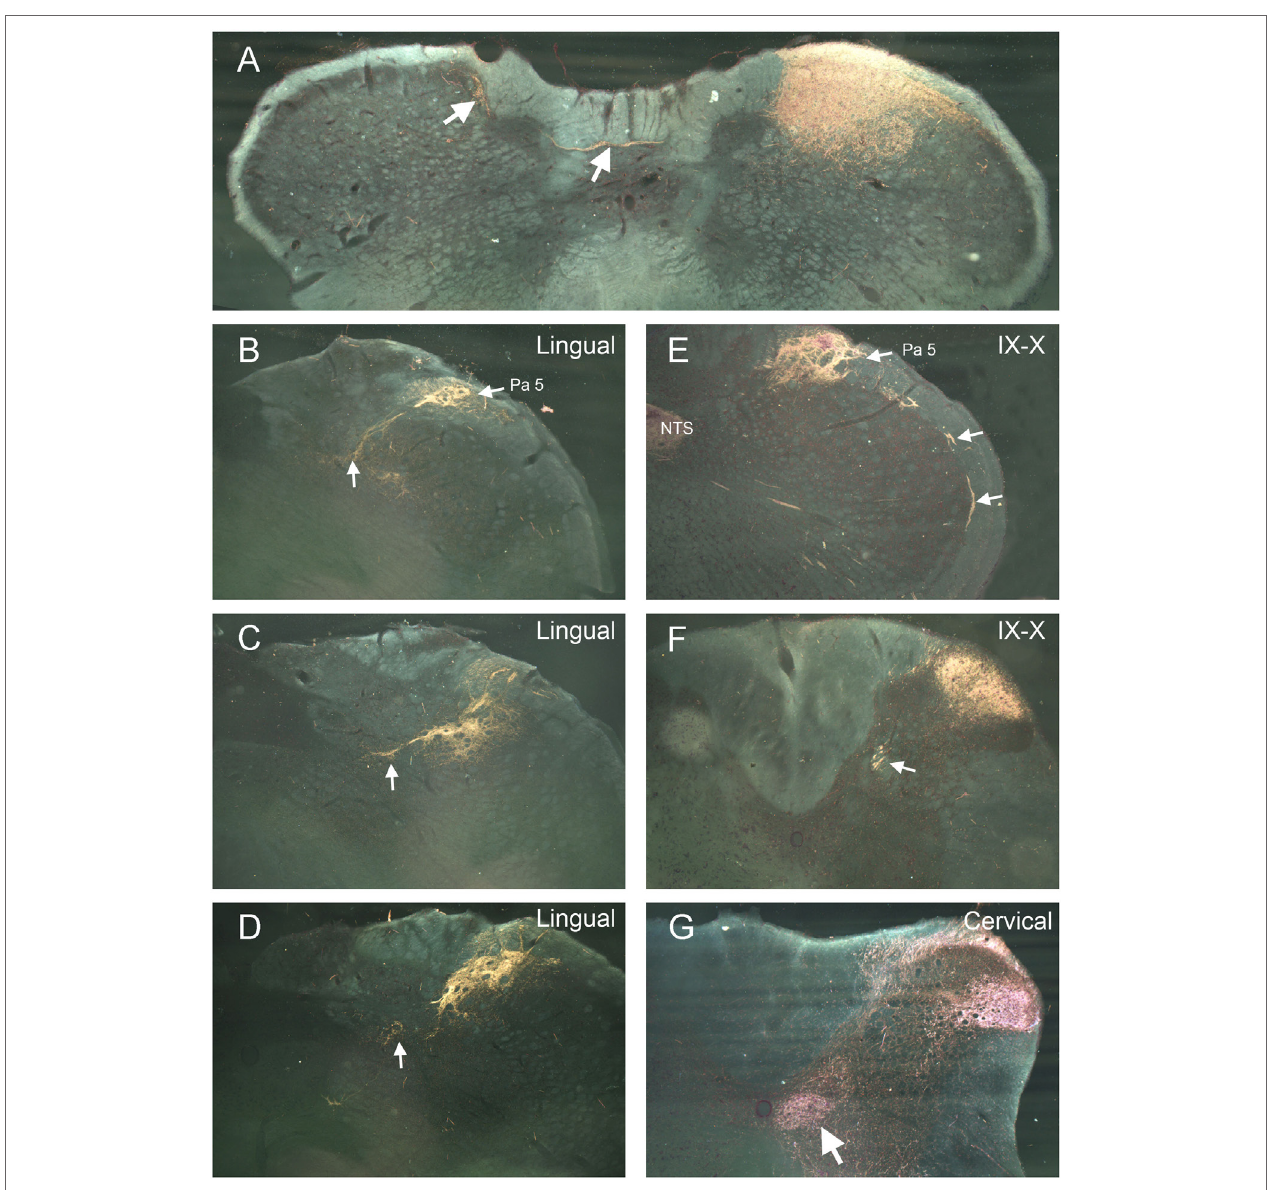
FigUre 2 | Darkfield photomicrographs illustrating selected projections after transganglionic transport of a horseradish peroxidase (HRP) cocktail injected into different nerves of the head and neck. Injections of cutaneous nerves with receptive fields along the midline, including the supraorbital and mental (the terminal branch of the inferior alveolar n.) nerves, resulted in reaction product in homologous areas of the contralateral trigeminocervical complex. The route for crossing fibers and their contralateral destination for the mental nerve (inferior alveolar n.) are shown (a) . Injections of the lingual nerve resulted in reaction product in the dorsolateral reticular formation, encroaching on the ventrolateral subnucleus of the nucleus of the solitary tract [ (B–D) ; arrows] as well as dense label in laminae I and II of the ipsilateral medullary dorsal horn (MDH) (D) . Panels (B,e) illustrate the dense reaction product in the paratrigeminal nucleus (Pa5) after injections of the lingual and IX/X nerves. Reaction product is seen in laminae I and II, the nucleus of the solitary tract (NTS), as well as intense label in the presumptive lamina I of the rostral MDH [ (e) ; arrows] after injection of IX/X nerves. It is well known that the glossopharyngeal and vagus nerves have receptive fields on the pinna; (F) shows reaction product in the rostral cervical dorsal horn is seen after injection of the IX/X nerves, presumably marking the central representation of the auricle. White arrow in (F) points to caudal extension of the solitary tract. Reaction product after transganglionic transport of the HRP cocktail in the greater occipital nerve is seen in all laminae of the ventrolateral cervical dorsal horn (g) as well as the central cervical nucleus [ (g) ; arrow].